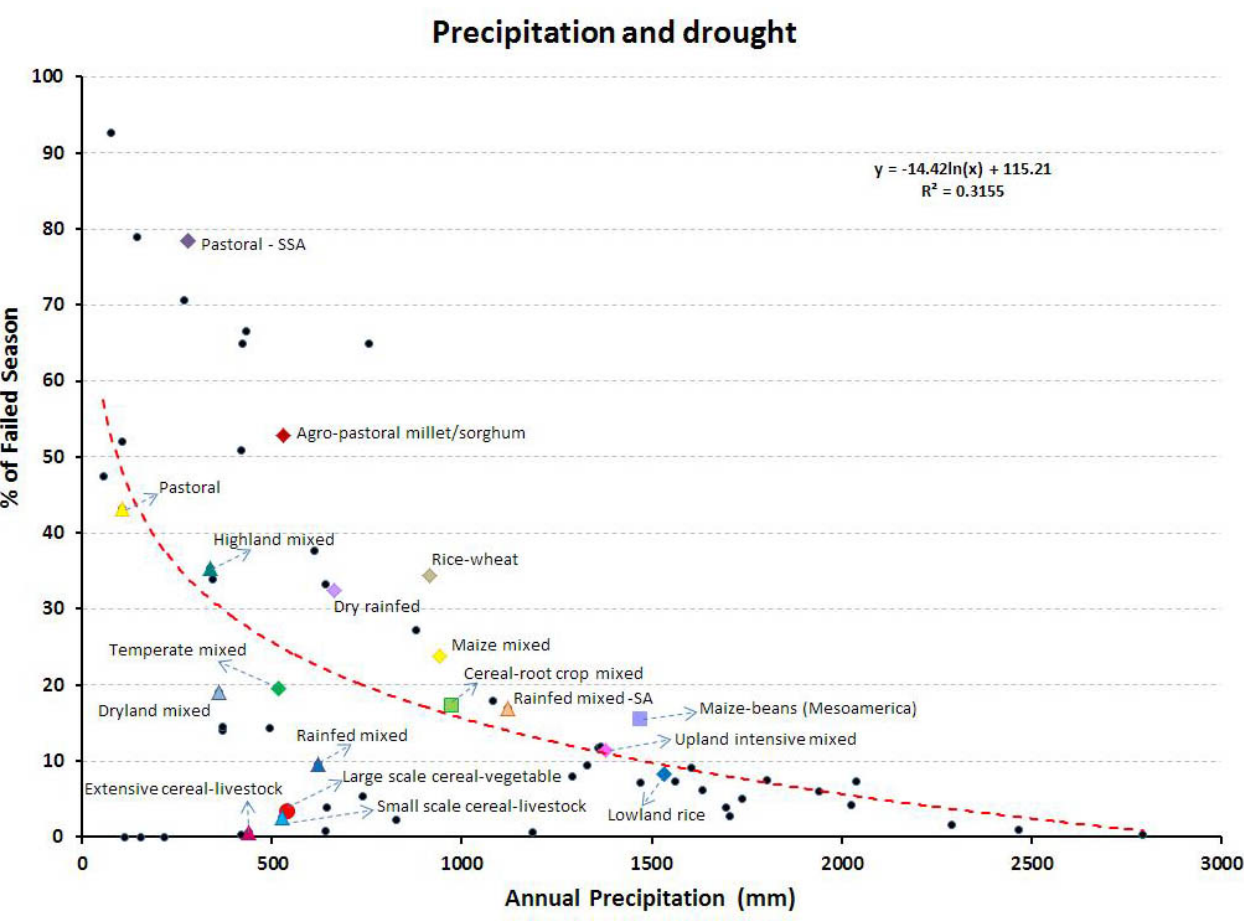
Figure 2. Average annual rainfall and average drought probability in 63 farming systems. Priority dryland cereal and legume farming systems are